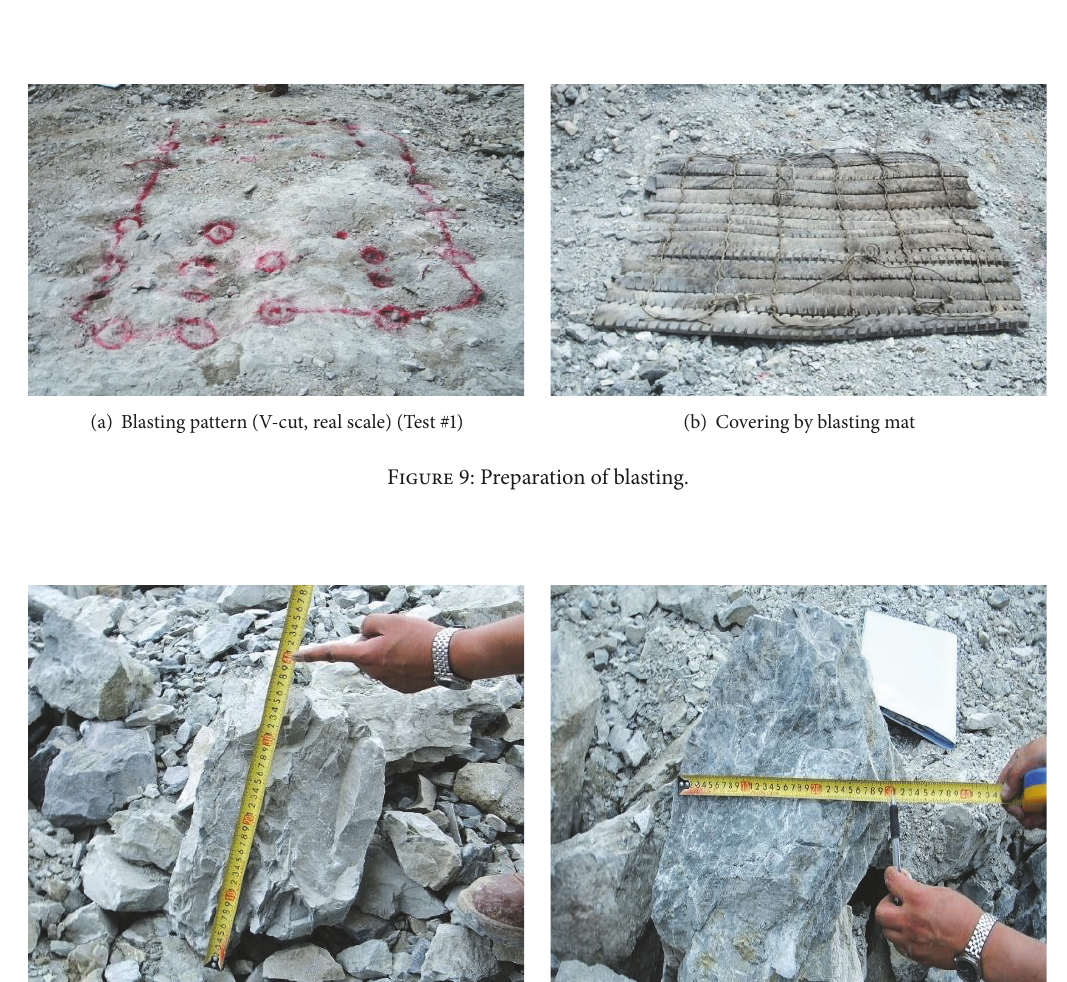
Figure 8: Performing blasthole-drilling.